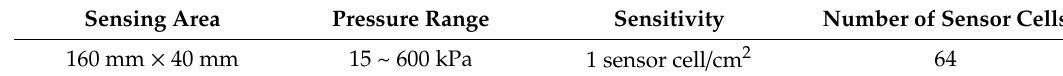
Table 1 Layers and size information of air pocket. Table 2. Specification of pressure sensor.